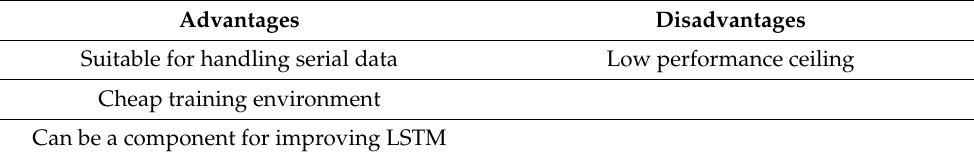
Table 2. The advantages and disadvantages of CRF.